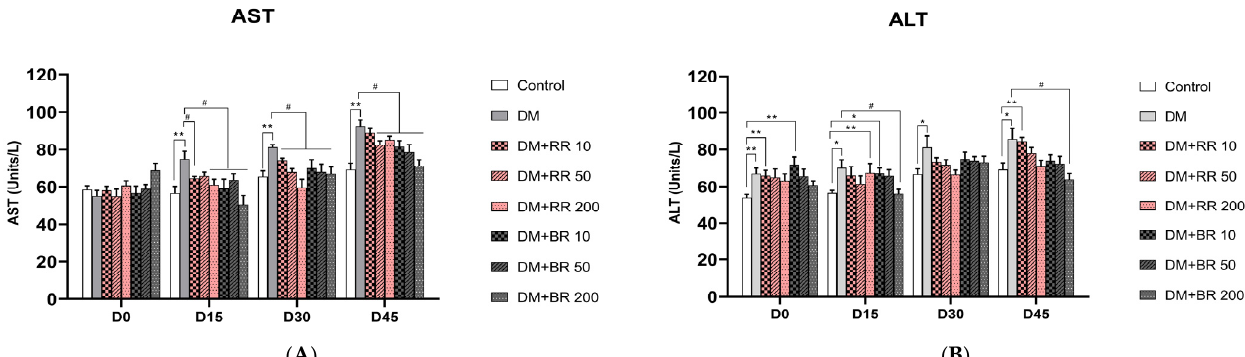
Figure 5. Effect of various doses of RR and BR at on AST ( A ) and ALT ( B ) levels in STZ-induced diabetic rats. * p < 0.05 and ** p < 0.01, diabetic control group vs. control group; # p < 0.05, treated group vs. diabetic control. Values represent mean ± S.E.M. (n =